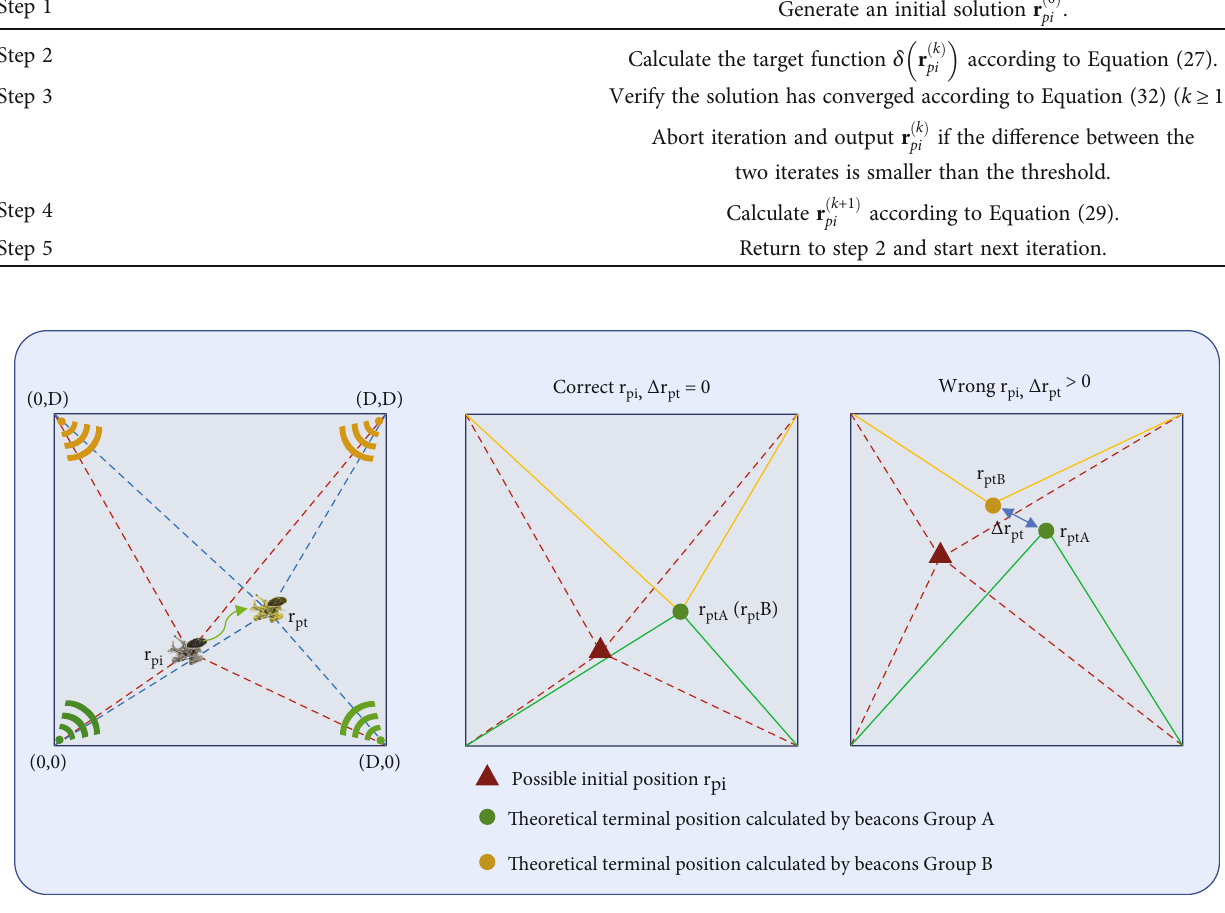
Figure 4: Positioning scene for lunar probe positioning.